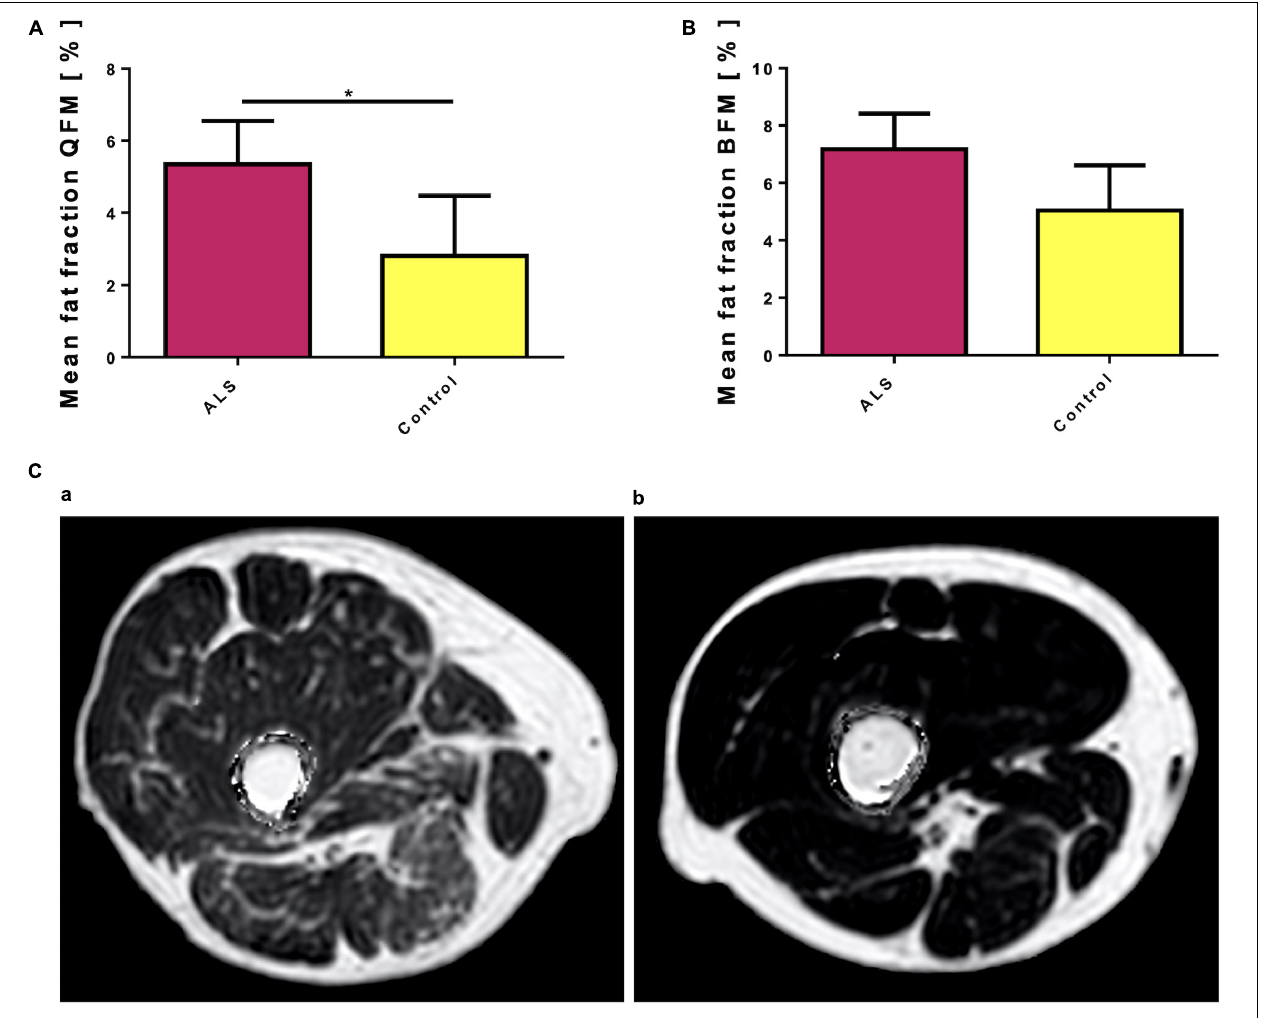
FIGURE 2 | (A) Mean fat fraction of the quadriceps femoris muscle (QFM) in ALS patients compared to controls. The quadriceps femoris muscle of ALS patients shows a higher fat fraction compared to healthy controls. Significant differences are indicated by asterisks (* p < 0.05, ** p < 0.01, *** p < 0.001). (B) Mean fat fraction of the biceps femoris muscle (BFM) in ALS patients compared to controls. The biceps femoris muscle of ALS patients shows a higher, but not significant higher fat fraction compared to healthy controls. (C) Two exemplary proton density fat fraction (PDFF) maps: Even in this rather severely affected patient (a), visually the increased intramuscular fat fraction of the investigated muscles (QFM and BFM) is hardly recognizable compared to a healthy control (b). However, quantitative evaluation of the Multi-echo Dixon showed increased intramuscular fat fractions for both muscle groups, although the difference was only significant for QFM. Note, that artifacts surrounding the thigh have been removed by software